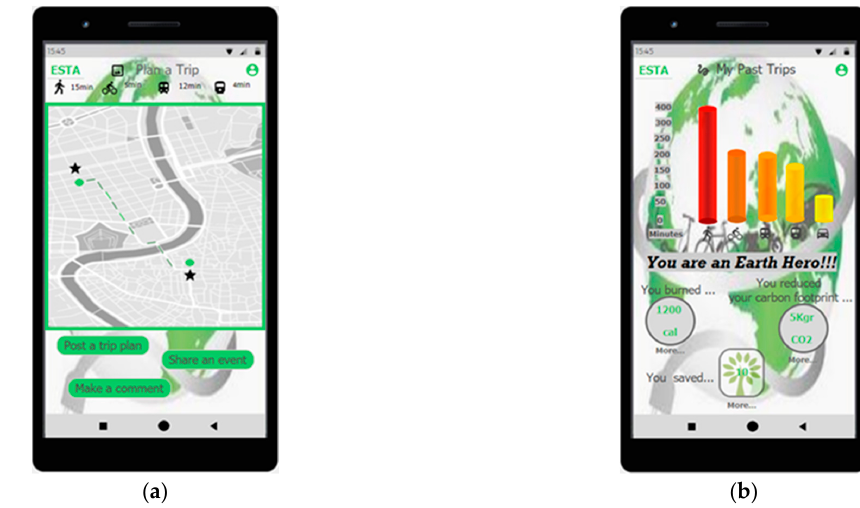
Figure 4. ( a ) Plan a trip Screen integrating social reinforcement, normative influence and cooperation; ( b ) My Past Trips Screen integrating self-monitoring and reminders weekly reflection, suggestion recognition, goal setting, influence on the emotion and cause-and-effect